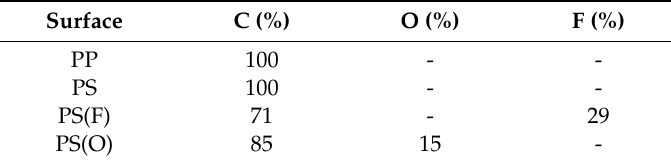
Table 1. X-ray photoelectron spectrometer (XPS) atomic concentration (%) of surfaces.